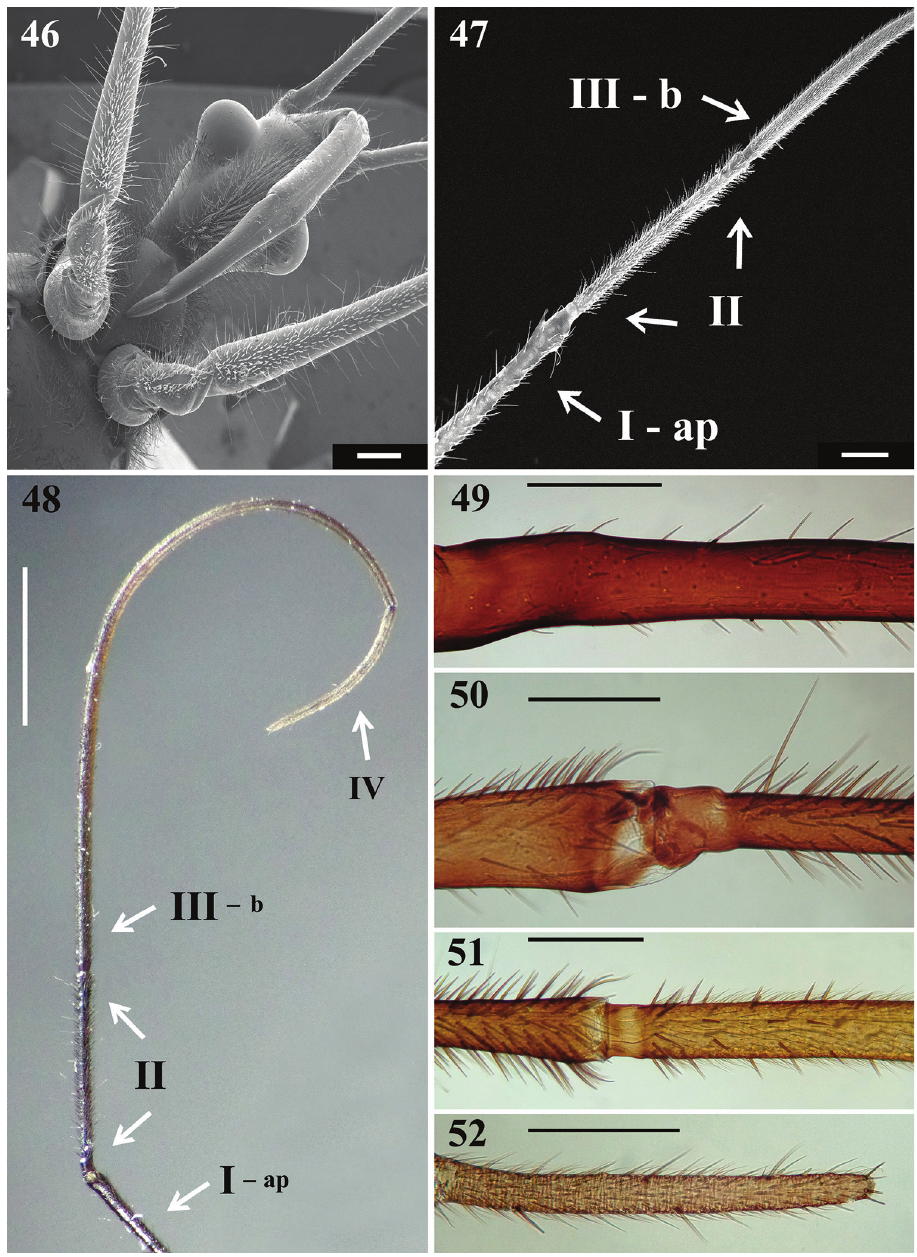
Figures 46–52. Parahiranetis salgadoi Gil-Santana, female. 46 head, fore coxae, fore trochanters and basal half of fore femora, ventral view 47–52 antenna 47 apex of segment I, segment II and basal portion of segment III 48 apex of segment I and segments II–IV. ( ap : apex; b : basal portion) 49 basal portion of segment I 50 apex of segment I and basal portion of segment II 51 apex of segment II and basal portion of segment III 52 apex of segment IV. Scale bars: 0.5 mm ( 46–47 ); 2.0 mm ( 48 ); 0.3 mm ( 49–52